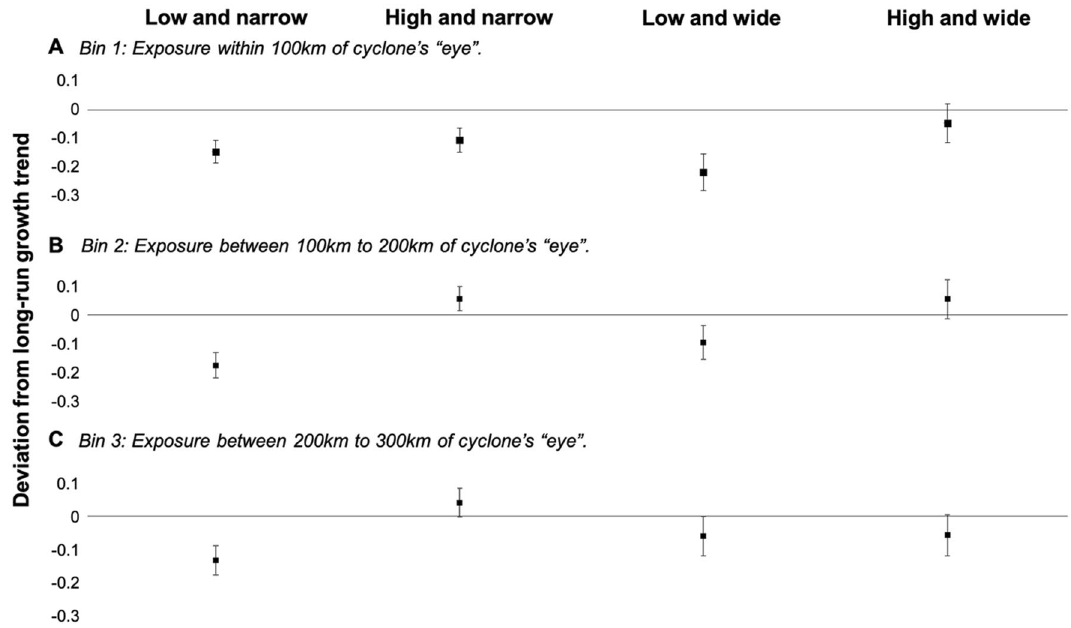
Figure 1. Five-year cumulative impact of tropical cyclone exposure on the growth trend in economic activity. ( A ) represents direct exposure within 100 km of a cyclone’s “eye” and ( B , C ) represent indirect exposure from 100 to 200 km of a cyclone’s and 200 km to 300 km of a cyclone’s “eye”. “Low” includes administrative units with a mean elevation < 50 m and “high” corresponds to mean elevation ≥ 50 m. “Narrow” includes administrative units with average mangrove width < 10 m of mangroves from the seaward boundary per m of coastline, and “wide” is average mangrove width ≥ 10 m per m coastline. 95% confidence intervals are provided around point